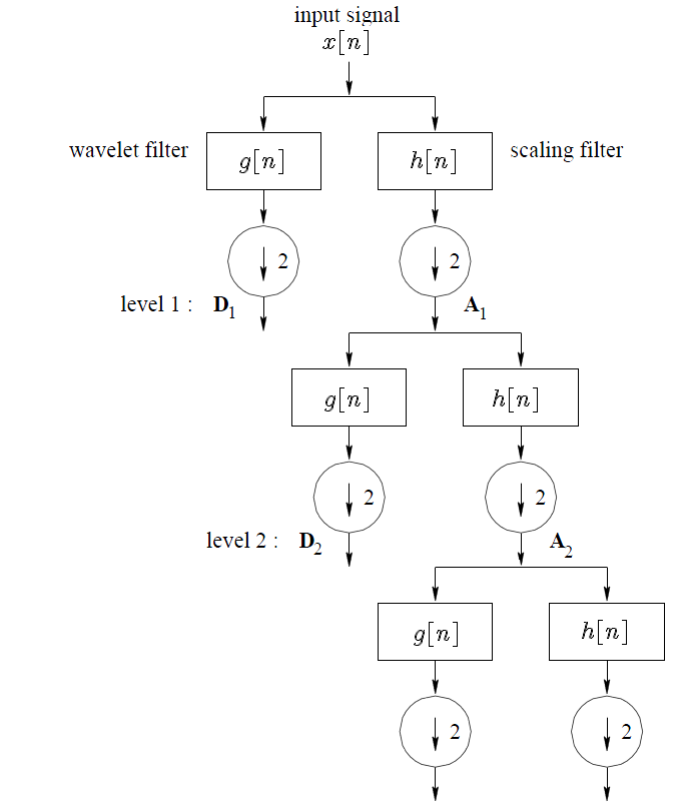
Figure 2. DWT decomposition of signal x [ n ]